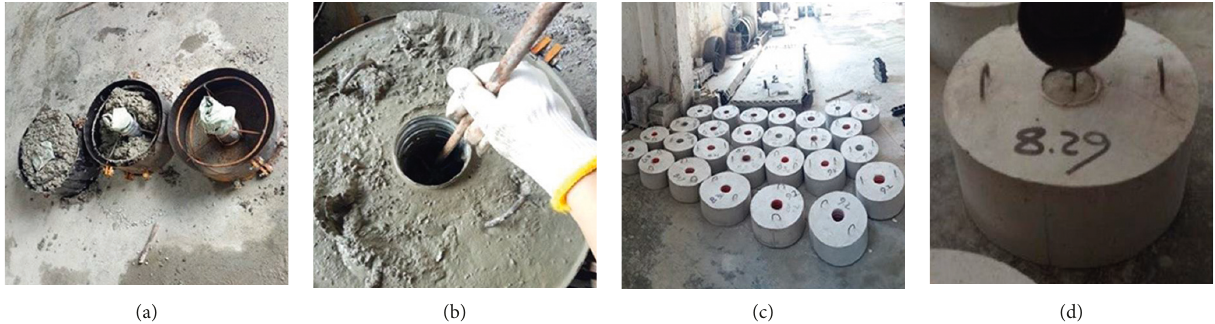
Figure 2: Specimen preparation, (a) Pour concrete, (b) Clean inside space, (c) Un-grouted specimen, (d) Grouted